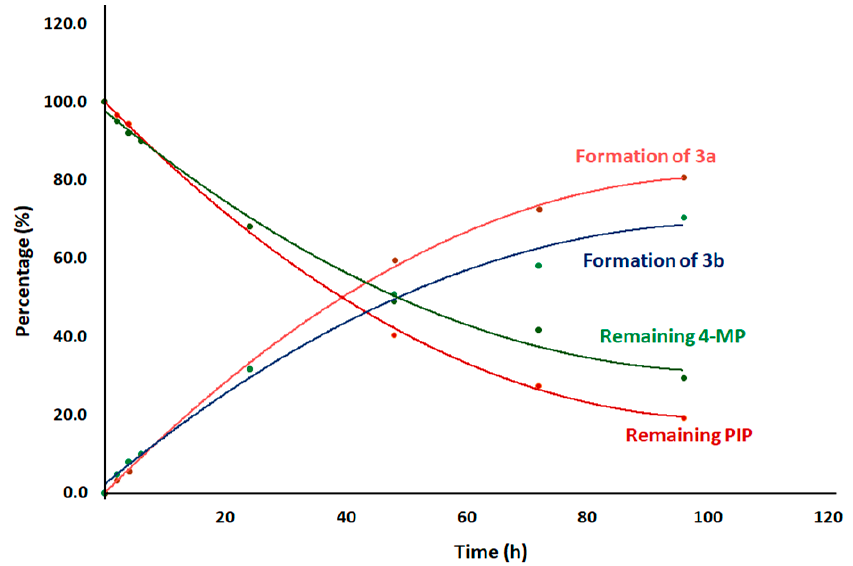
Figure 1. Evolution of the reaction of piperidines with GVL.